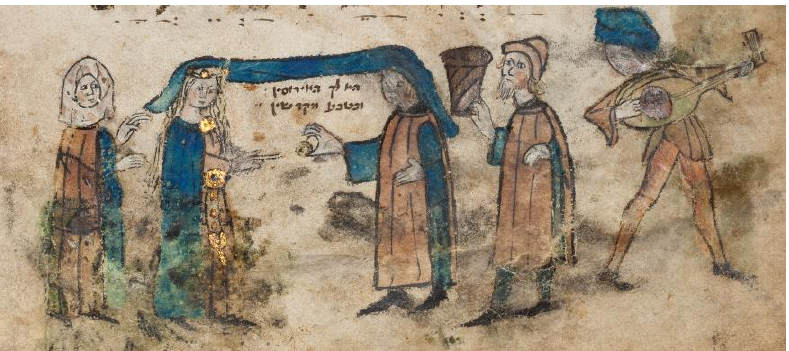
Figure 1. marriage of Moses to Zipporah; a contemporary wedding scene from the 15th